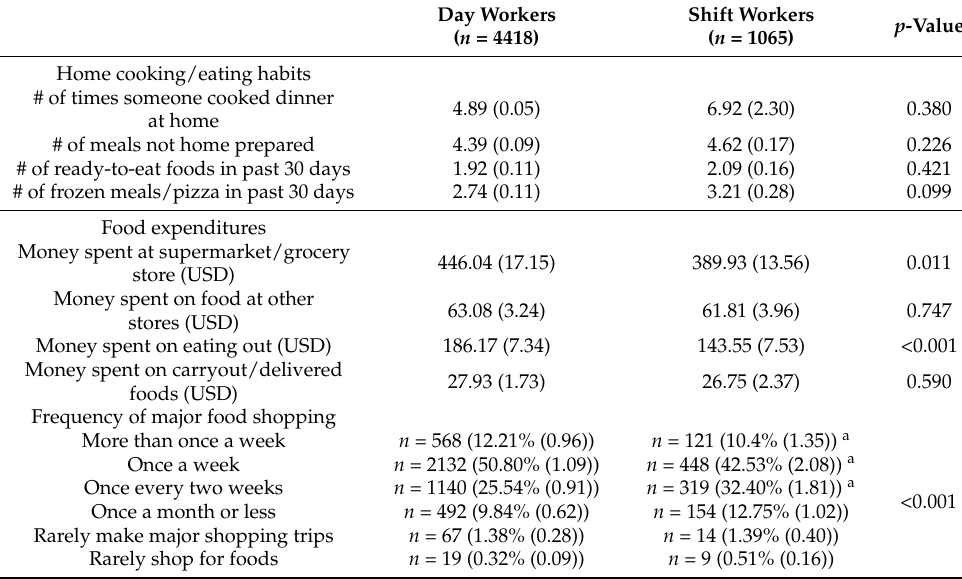
Table 3. Consumer behavior in day workers and shift workers: an overview.